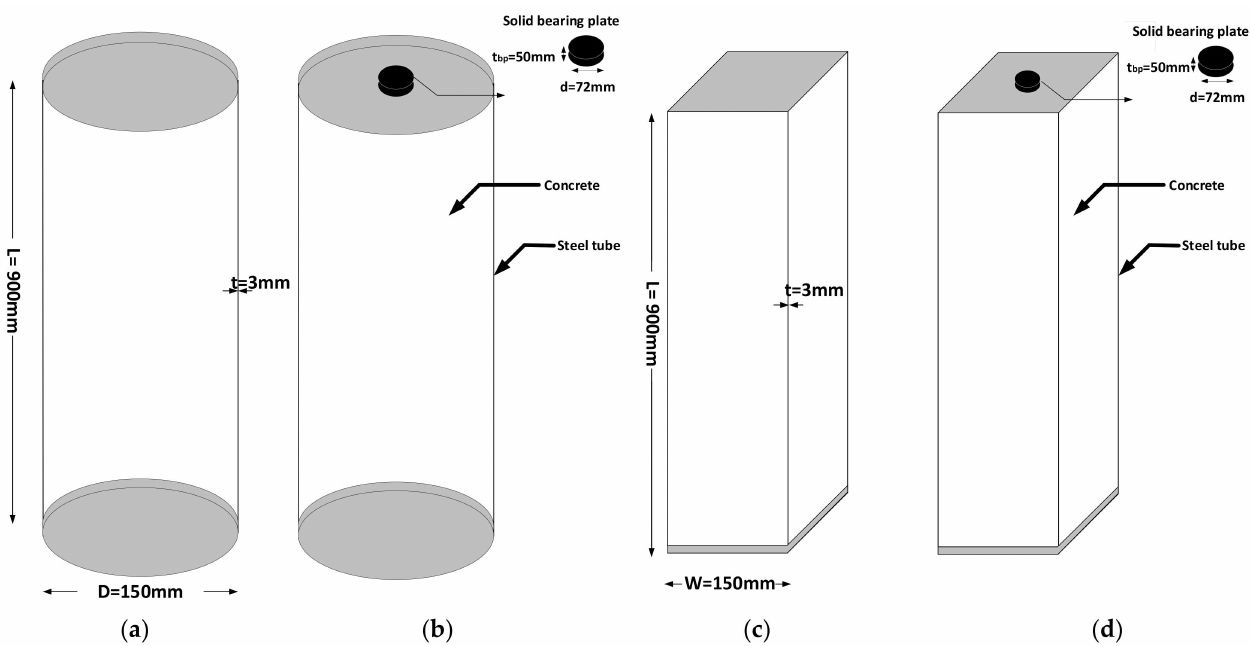
Figure 1. Cross-section of ( a ) CCFST under full compression, ( b ) CCFST under partial compression, ( c ) SCFST under full compression, ( d ) SCFST under partial compression.